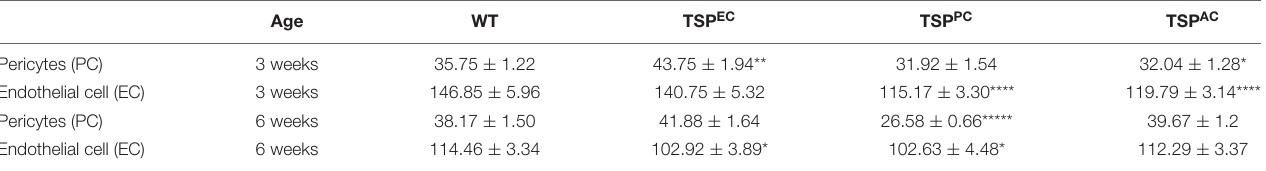
TABLE 1 | Retinal vascular cell numbers.